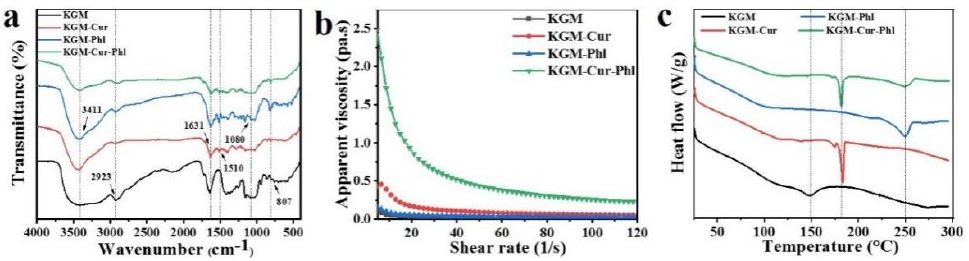
Figure 2 . Characterization of konjac glucomannan coatings: ( a ) FTIR, ( b ) steady rheological behavior and ( c ) DSC.